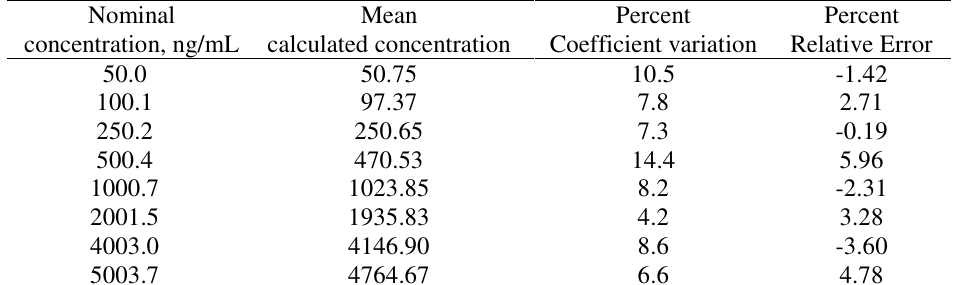
Table 2. Precision of plasma calibration curve standards (n =